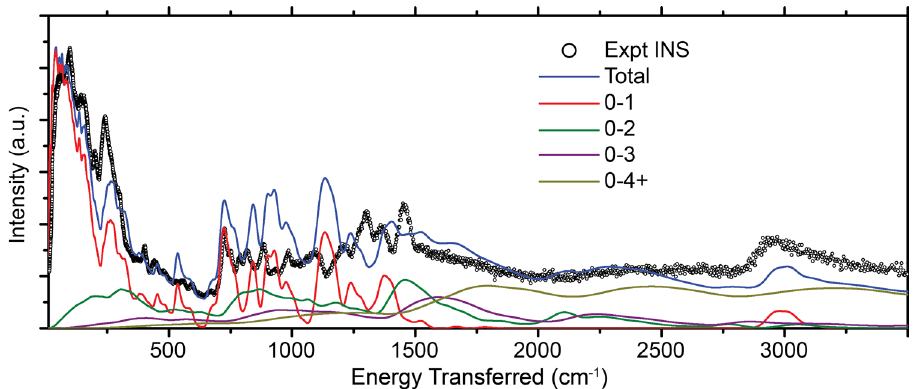
Figure 2. Comparison between experimental INS spectrum for crystalline P3HT (defined as the difference between the semicrystalline spectrum and 55% of the amorphous spectrum) and a simulated spectrum from molecular dynamics. The spectral contributions for individual overtones are also shown. The MD spectrum was convolved by a variable width Gaussian with σ = 0.01E, where E is the energy transfer given by the values on the horizontal axis of the